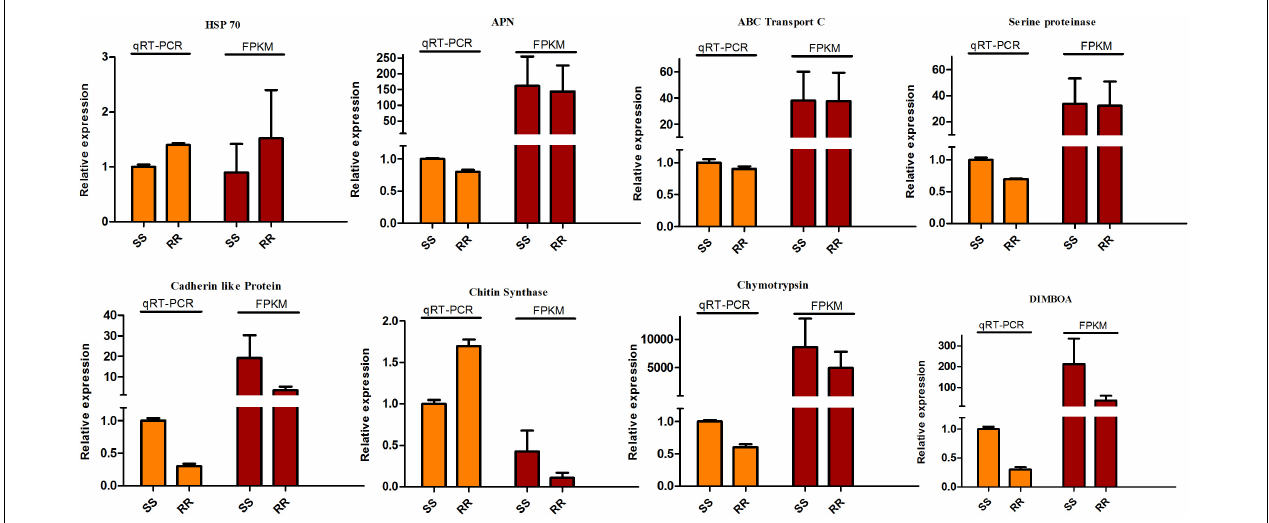
FIGURE 6 | The qRT-PCR analysis of differentially expressed genes to confirm expression patterns indicated by sequencing. The DEGs were randomly selected for qRT-PCR. Three technical replicates were performed for each of the three biological replicates. The height of each bar chart represents the mean average of sample-specific 2 − (cid:49)(cid:49) Ct